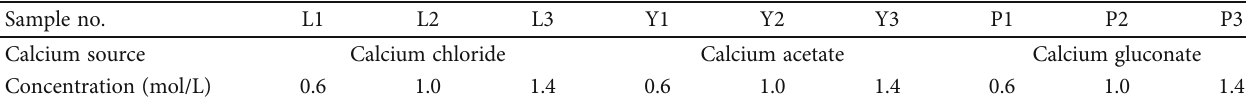
Table 3: Sample no. and binder con fi